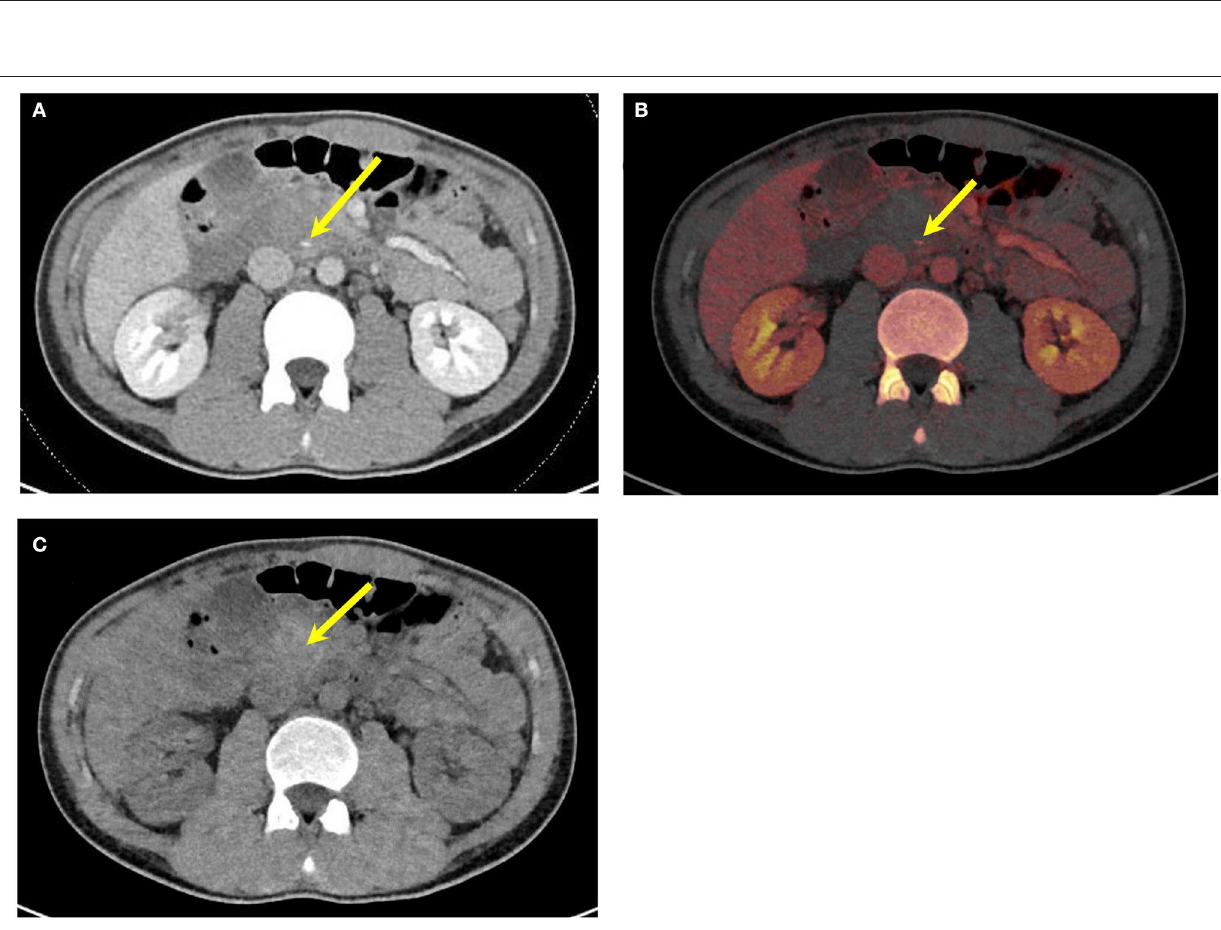
Frontiers in Radiology |